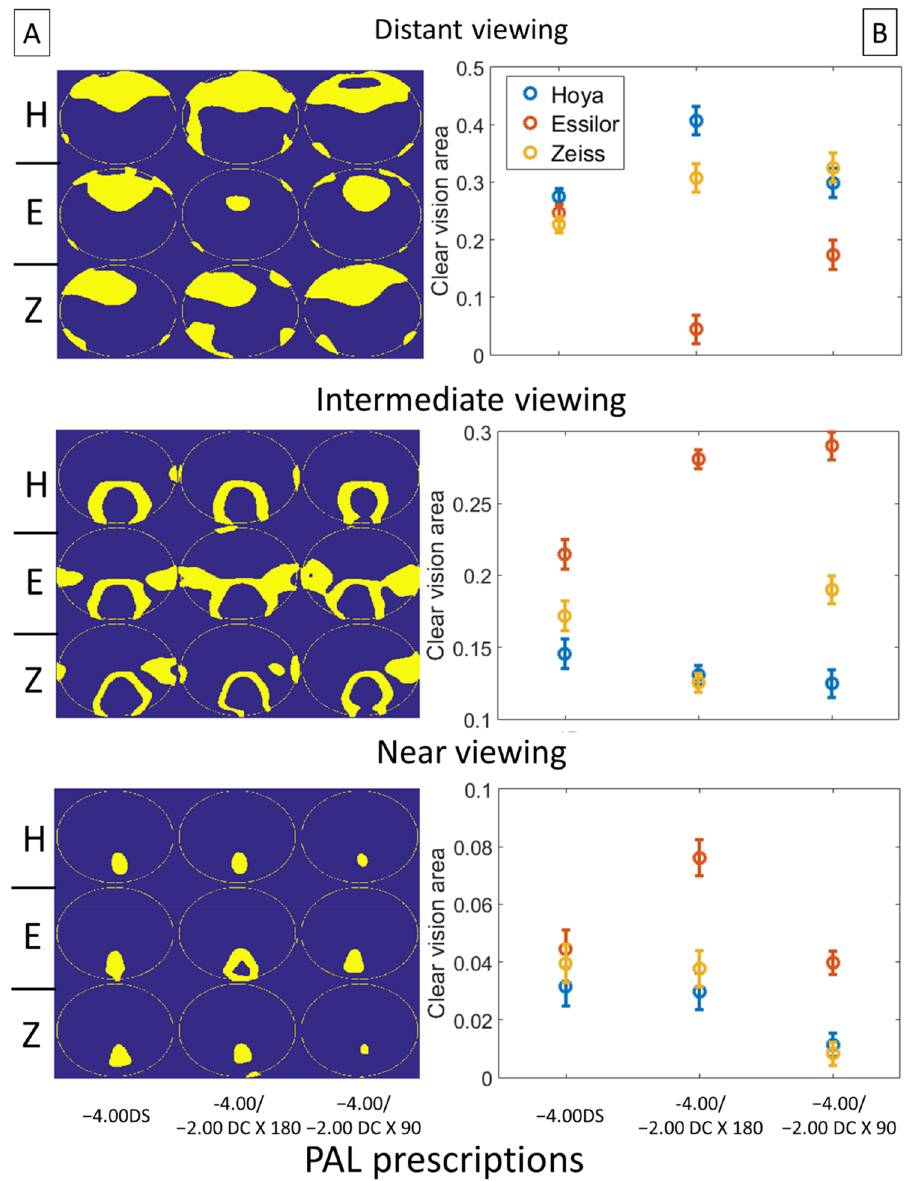
Figure 10. Area of clear vision of different PALs for distant, intermediate, and near viewing distances, metric (cid:31) M . ( A ) Binary image showing area of clear vision (yellow) and area with (cid:31) M more than ± 0.25D from the target prescription (blue). The calculations in each plot were based on data of four lenses with the same prescription. H Hoya, E Essilor, Z Zeiss. ( B ) Proportion of clear vision area as a function of PAL prescription. The proportion was calculated as area of clear vision to the total area of measurement. Error bars represent standard